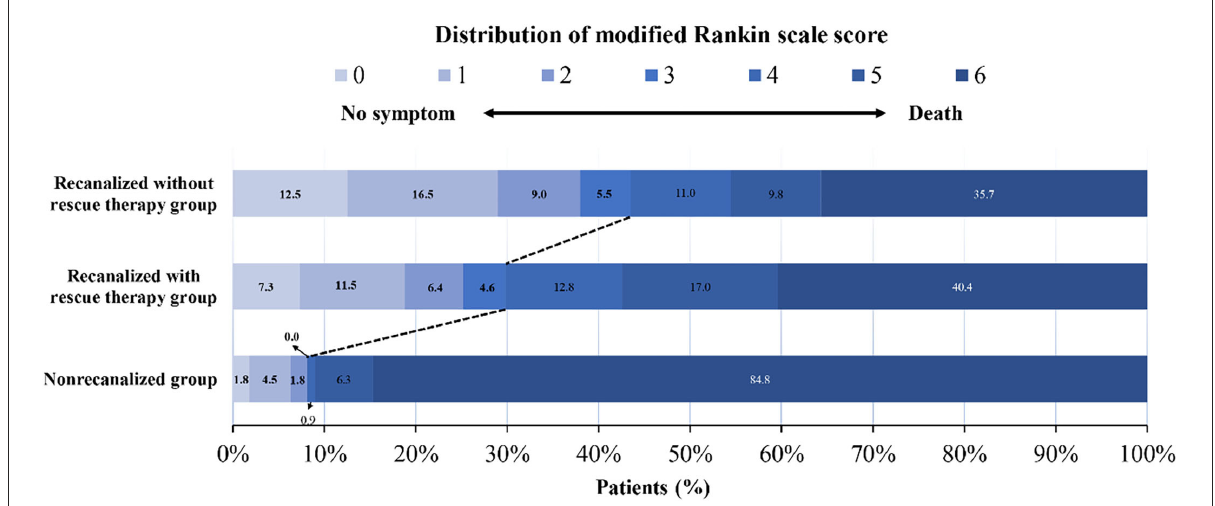
FIGURE1 Distribution of scores on the modified Rankin Scale (mRS) at 90 days. The distribution of the mRS scores for favorable functional outcomes and mortality among patients in the non-recanalized group and in the recanalized with or without rescue therapy group. The numbers in the charts are percentages of patients who had each score, and the percentages may not sum to 100% owing to